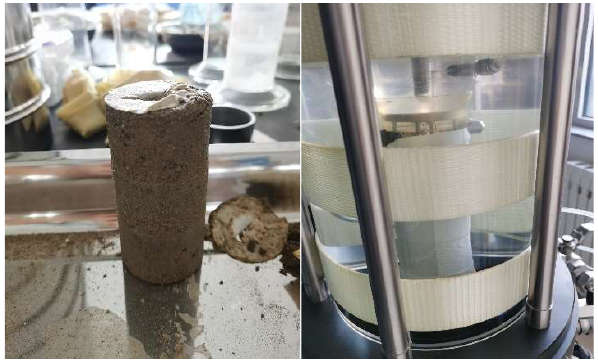
Figure 5. Breakdown samples.